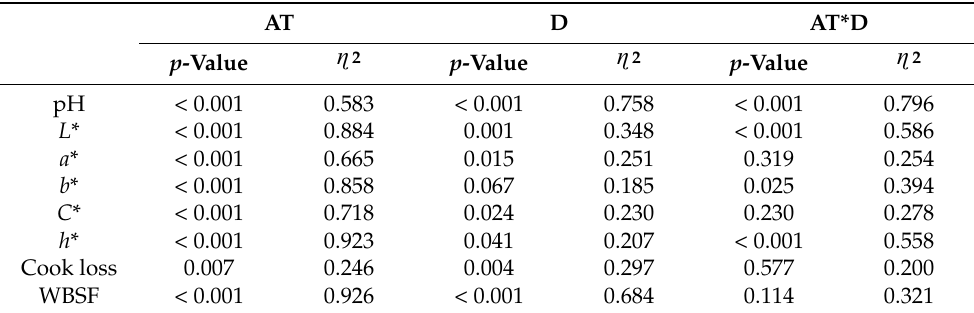
Table 5. Statistical parameters on the effect of ageing time (0, 7, 14 and 21 days), slaughter day (5 consecutive weeks) and ageing time*slaughter day on pH, instrumental color ( L *, a *, b *, C* , h* ), cook loss (%) and Warner-Bratzler shear force (N) measurements in horse longissimus thoracis and lumborum muscle ( n = 20).